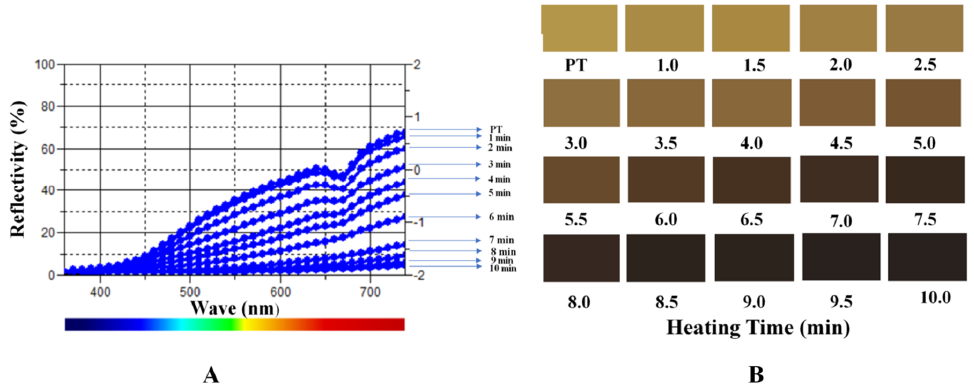
Figure 2. The reflectivity of the PT in heating process ( A ) and the colors of samples ( B ).